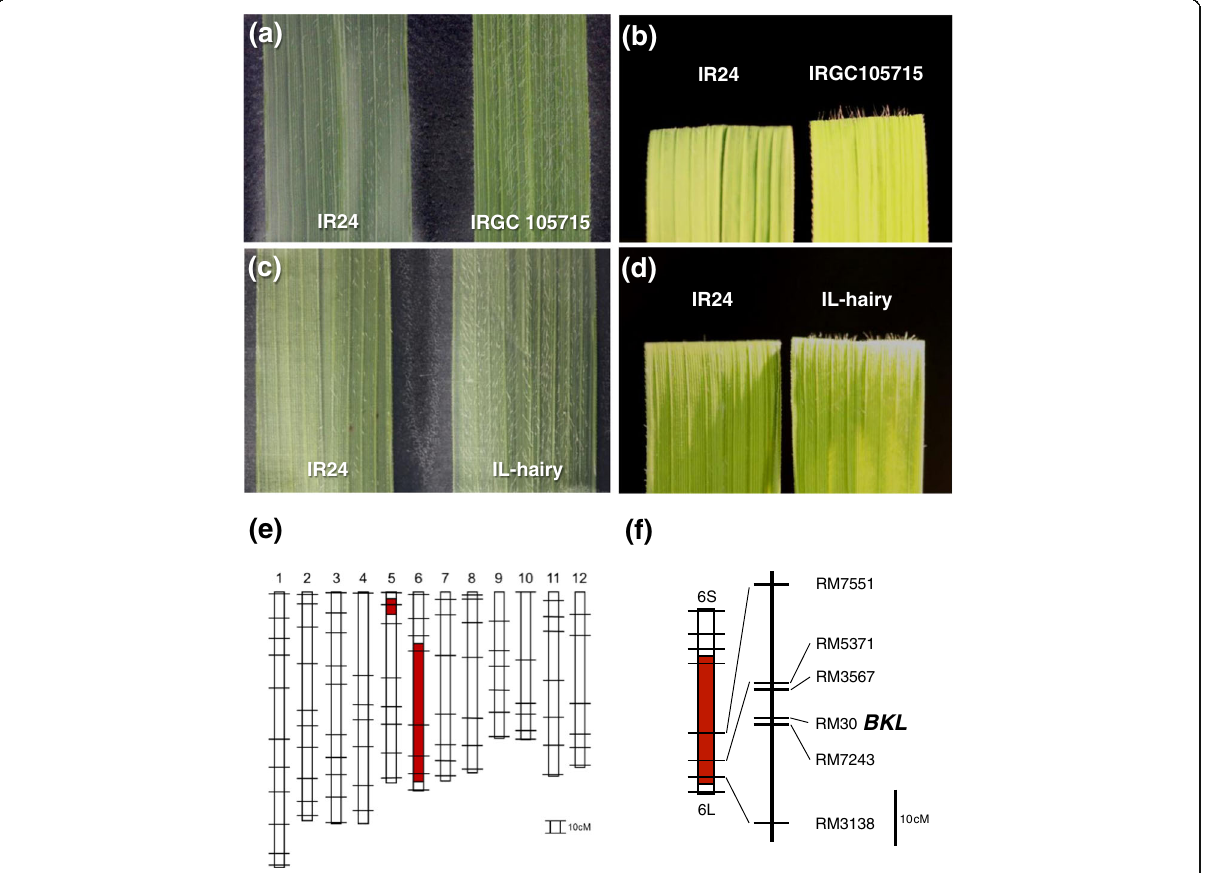
Fig. 1 Phenotypes of leaf surface, graphical genotype of IL-hairy, and linkage map of BKL on chromosome 6. a – d Phenotypes of leaf hairs in vertical ( a, c ) and horizontal ( b, d ) view of IR24 and IRGC105715 ( a, b ) and IR24 and IL-hairy ( c, d ). e Graphical genotype of IL-hairy used for linkage analysis in BC 5 F 2 . Chromosomal segments derived from IRGC105715 and IR24 are indicated in red and white , respectively. f Vertical bars represent the positions of SSR markers. Numbers indicate map distances (cM) between SSR